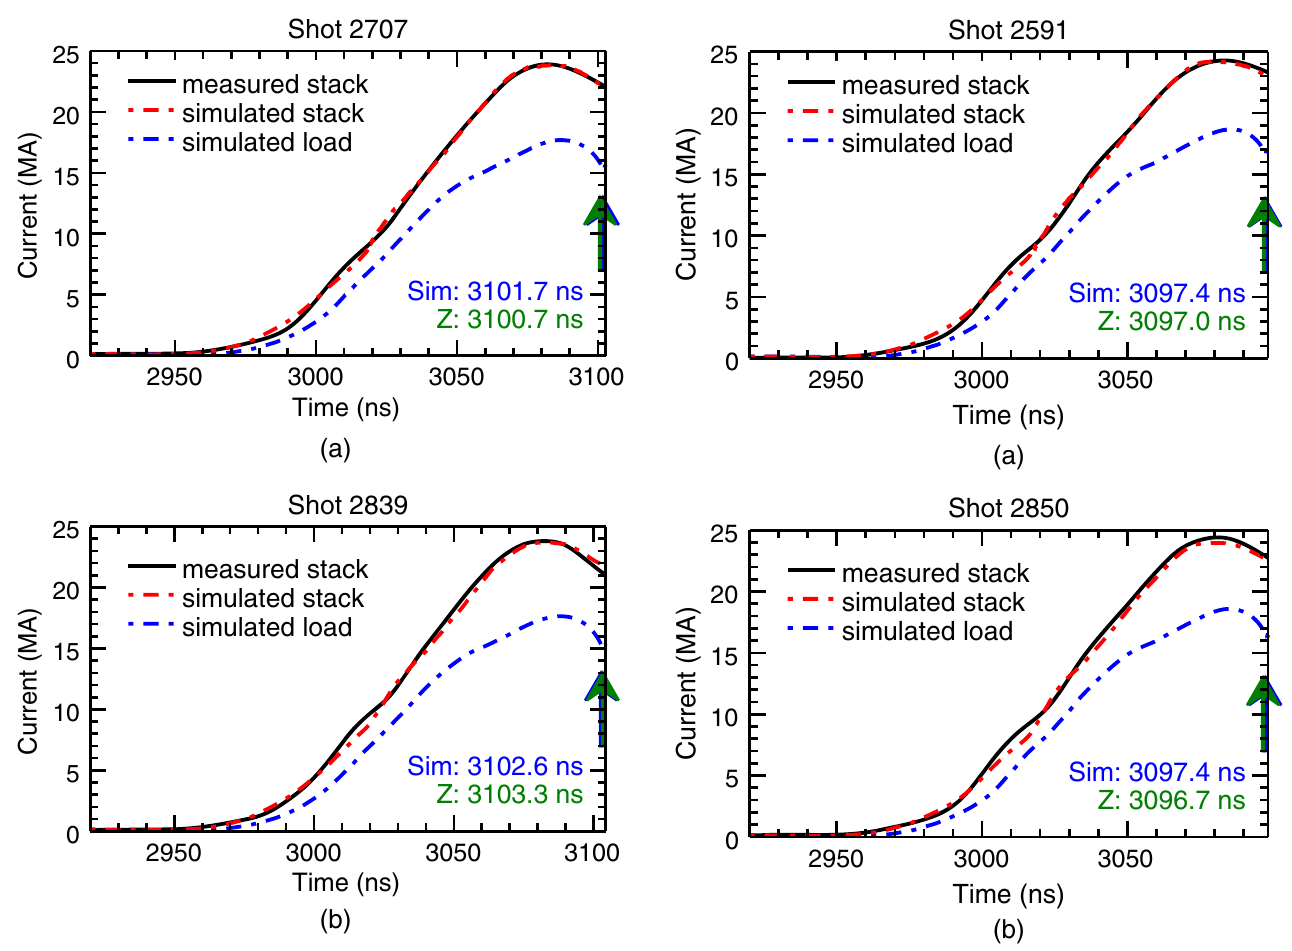
FIG. 5. Comparison of simulation and experiment results of two integrated MagLIF shots with a 10 mm liner [5]. (a) Z shot 2707, (b) Z shot 2839.